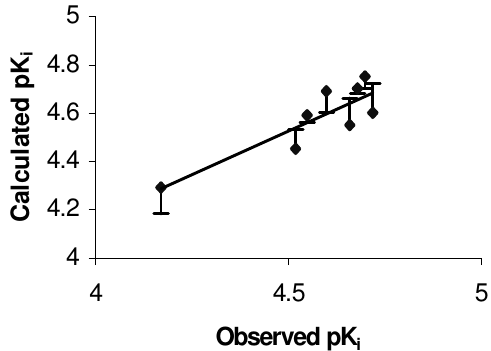
Figure 5. Plot between observed pK